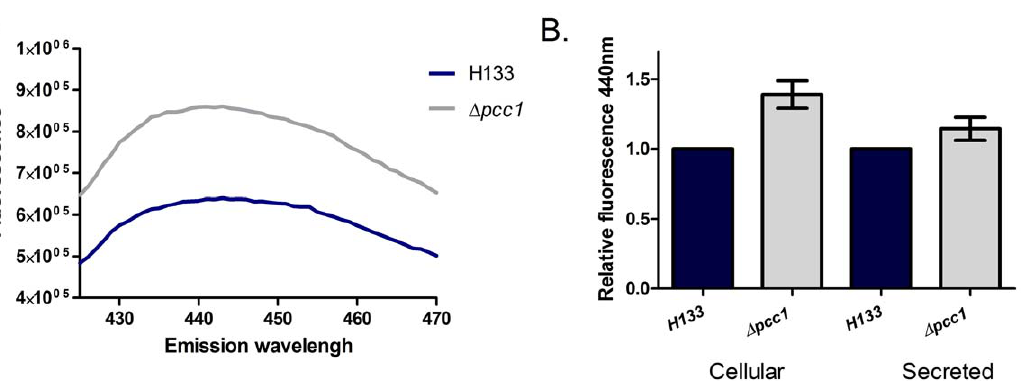
Figure 2. Advanced glycation products in wild type Haloferaxvolcanii and the D pcc1 mutant cells. A . Measurement of AGEs-specific fluorescence in the H133 (wild-type) and in D pcc1 (HAN16). The emission spectrum from 400 nm to 480 nm upon excitation at 370 nm is presented. A representative sample is shown. B . Accumulation and secretion of AGEs. AGE-specific fluorescence is shown relative to the wild-type. The results represent three independent experiments, error bars indicates standard error of mean.